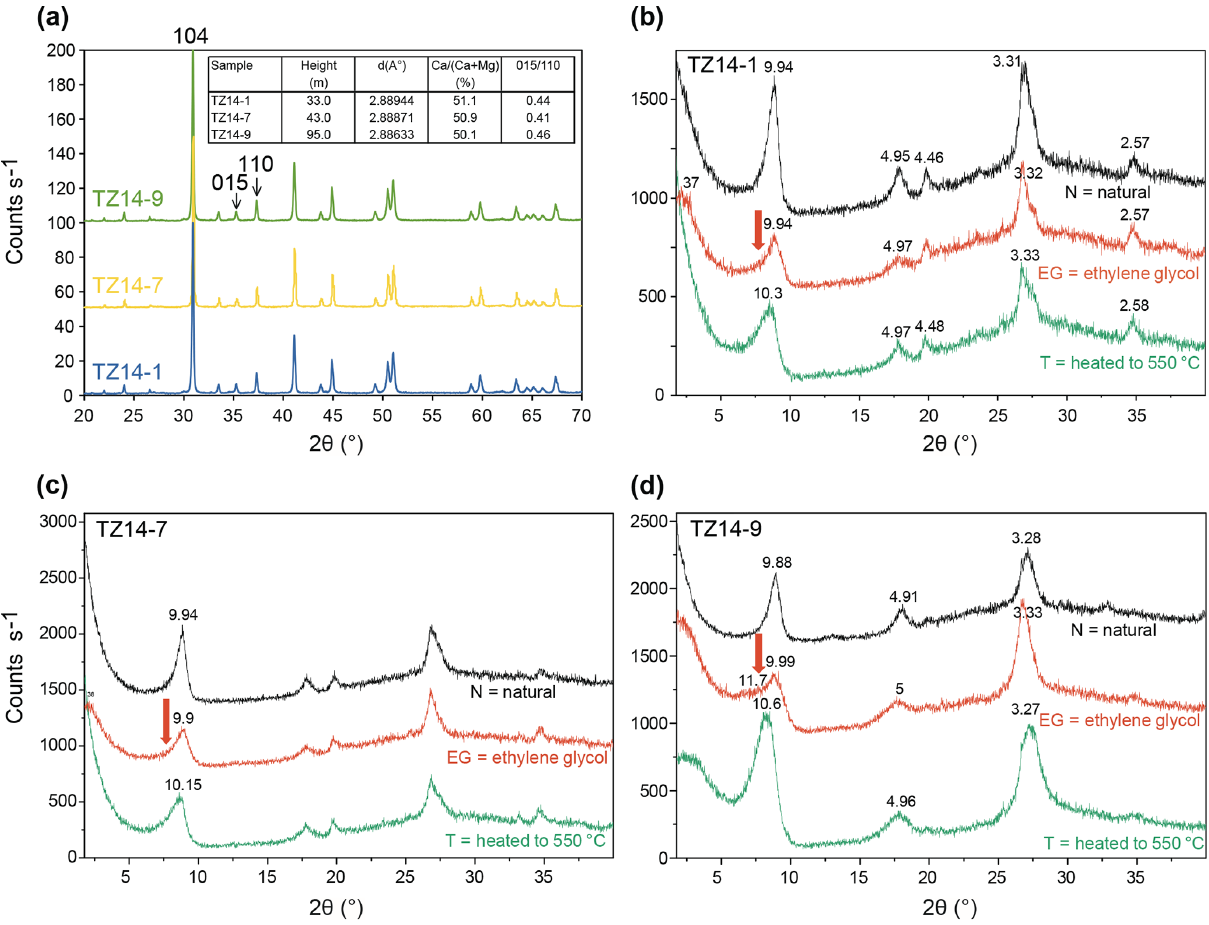
Figure 7. X-ray diffraction patterns: (a) bulk analyses of homogeneous dolomite (samples TZ14-1, TZ14-7, and TZ14-9); main peaks and ordering peaks are labelled with (hkl) indices. The inset in (a) shows the Mg /( Ca + Mg ) ratios in the dolomites determined from the shift of the 104 peak using the equation of Lumsden (1979) and the structural ordering calculated from the ratio of the 015 ordering peak to the 110 peak according to Füchtbauer and Goldschmidt (1966). (b–d) Clay mineral separates of samples TZ14-1, TZ14-7, and TZ14-9, air dried (N), saturated with ethylene glycol (EG), and heated to 550 ◦ C (T); d values in Å. The illite–smectite mixed layer is best seen in the ethylene-glycol-saturated sample TZ14-9. The arrow points to the expandable (smectite) part of the mixed